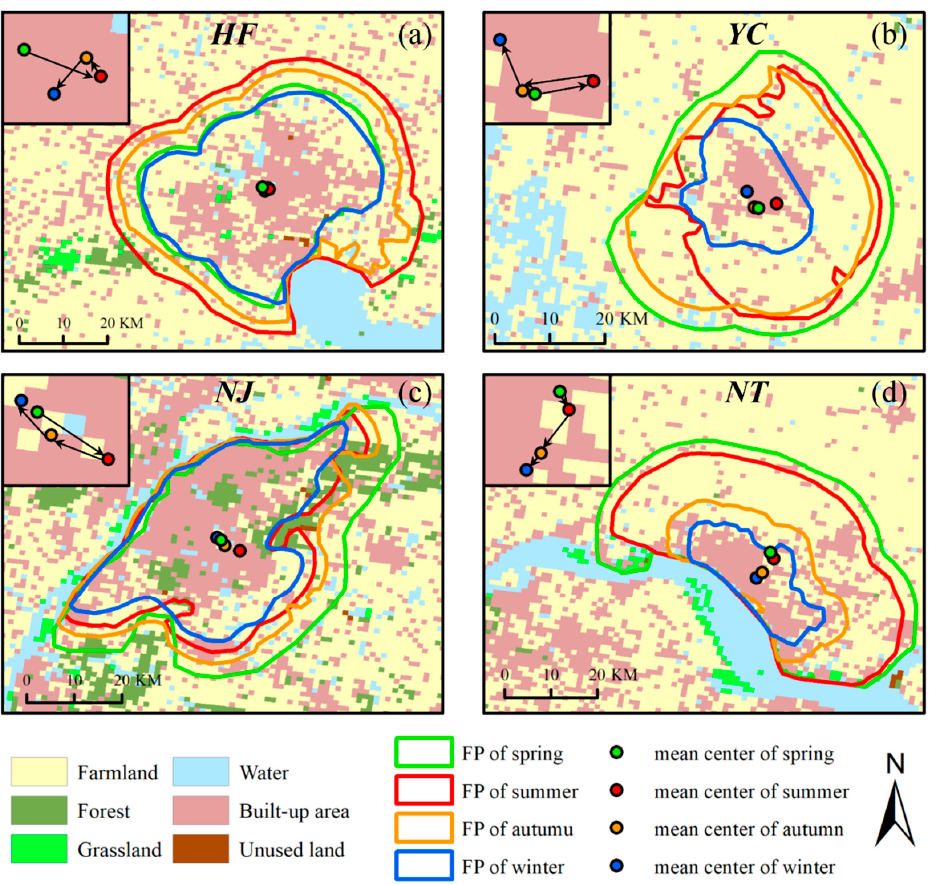
Figure 9. Footprint and mean center of four cities in different seasons of 2020. ( a ) Hefei; ( b ) Yan- cheng; ( c ) Nanjing; ( d ) Nantong. ( c ) Nanjing; ( d )